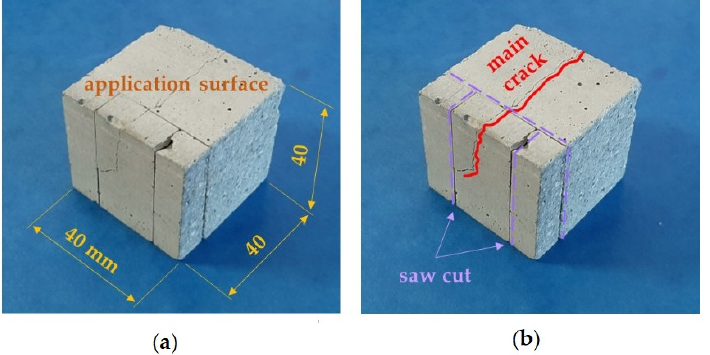
Figure 3. Mock-up cut to obtain smaller samples suitable for OM and SEM analysis: ( a ) application surface for the different protective treatments; and ( b ) typical location of the main crack and saw cuts.